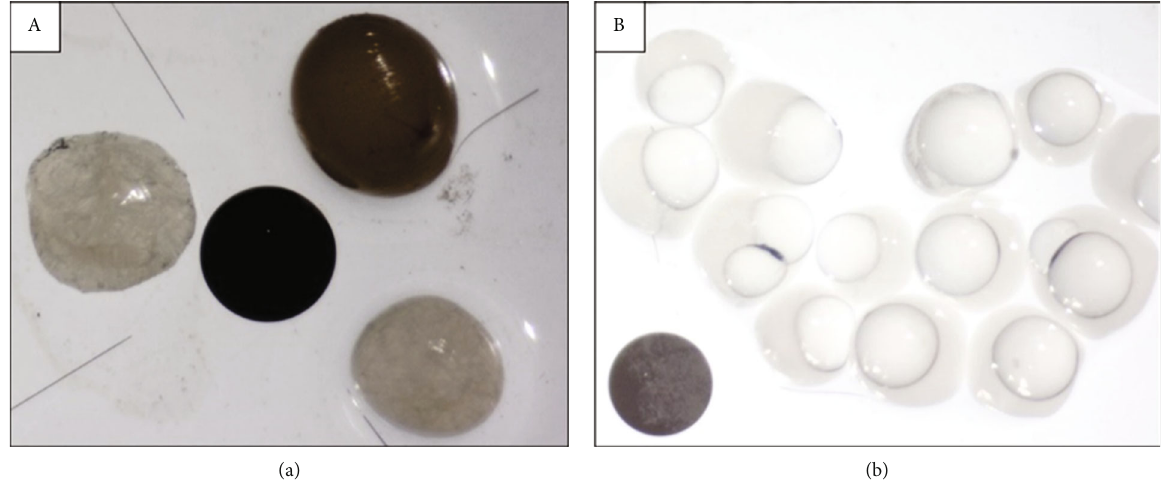
Figure 4: Observation under binocular magni fi er. (a) Single alginate bead (dark) and two aqueous core capsules of di ff erent nozzle sizes (450-900 μ m and 300-500 μ m) compared to the center (black disk) of size 1.5mm. The diameter of the capsules is around 2mm, 1.84mm, and 1.45mm, respectively. (b) Oil-core capsules obtained with 450-600 μ m nozzle sizes. Sizes are around 1 : 45 ± 0 : 21